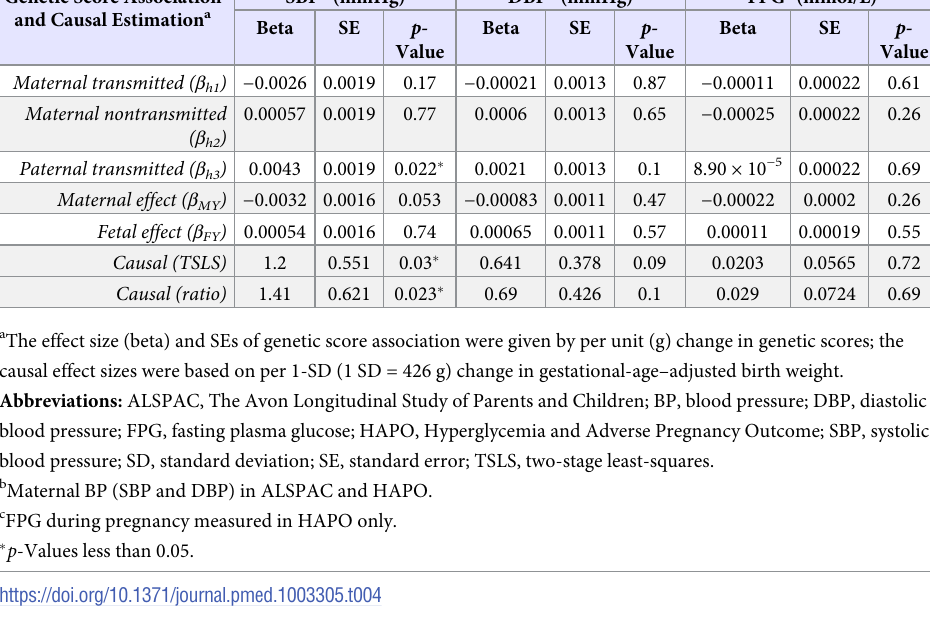
Table 4. Associations between birth weight genetic scores and maternal BP, glucose levels, and estimated causal effects per 1-SD changes in gestational-age–adjusted birth weight. Genetic Score Association and Causal Estimation